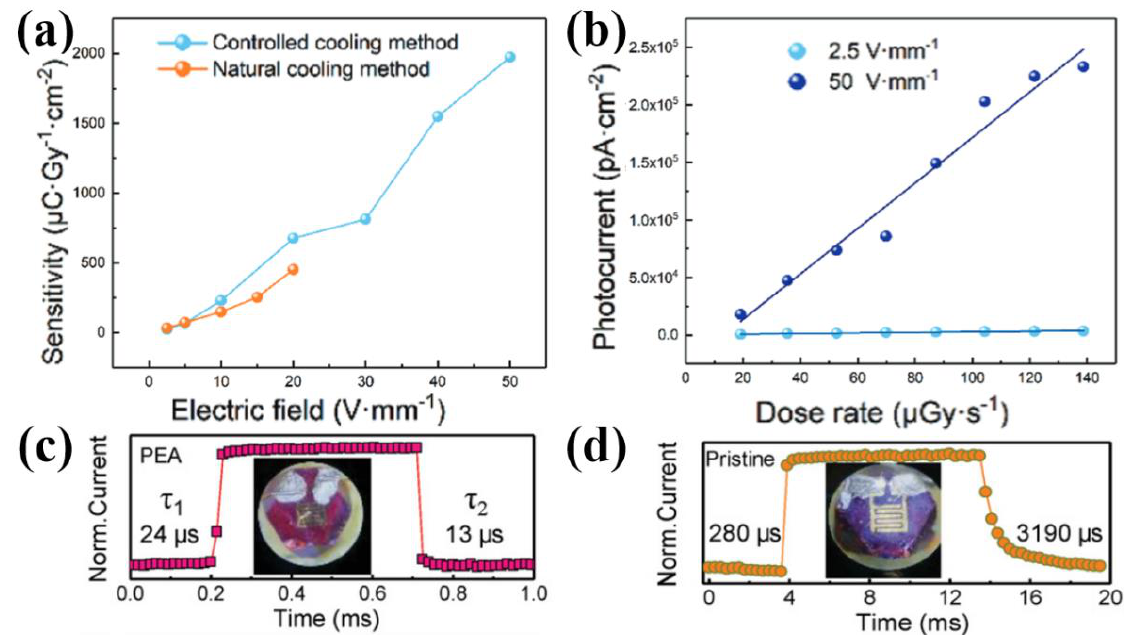
Figure 2. ( a ) The sensitivity of controlled-cooling-based Cs 2 AgBiBr 6 single crystals under different electric field intensities [32]. ( b ) Photocurrent response to X-ray dose rate under electric field intensities of 2.5 V mm − 1 and 50 V mm − 1 [32]. Photocurrent response of PEA-Cs 2 AgBiBr 6 ( c ) and pristine Cs 2 AgBiBr 6 ( d ) single crystal X-ray detector [33].